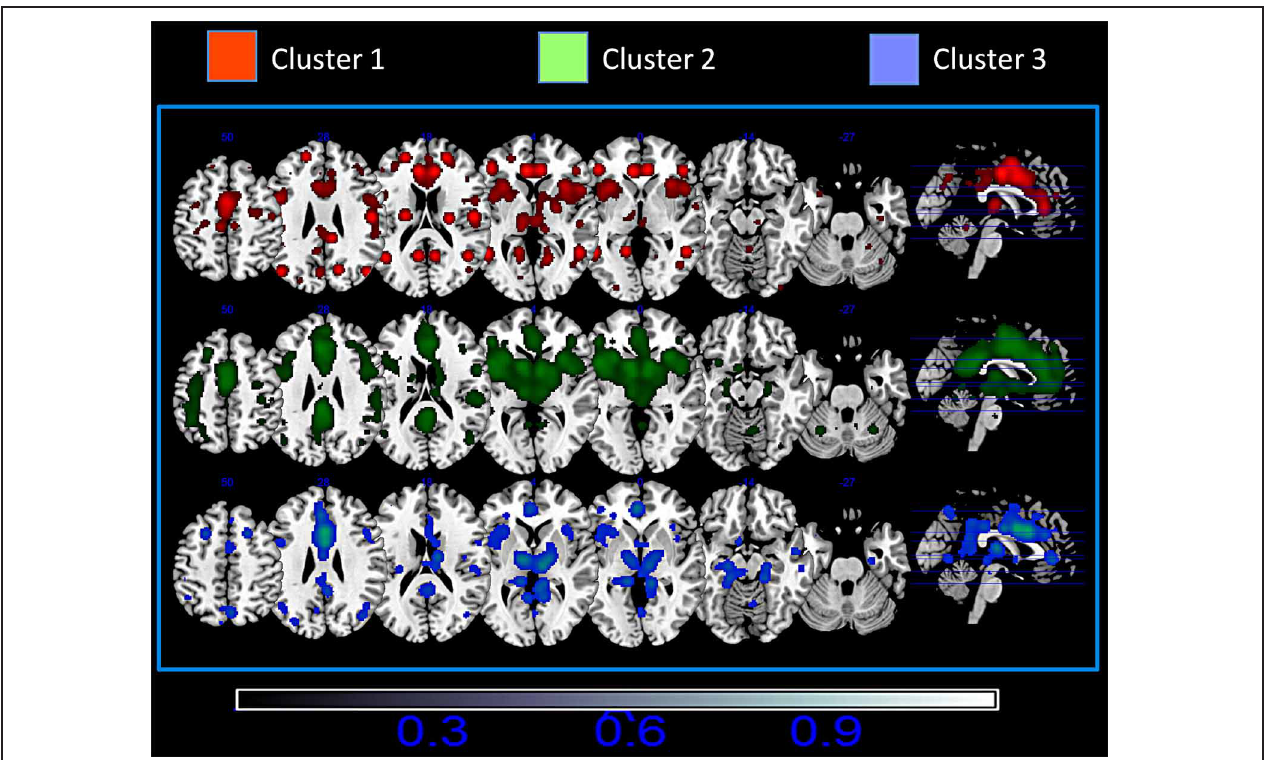
FIGURE 4 | Mean Meta-analytic connectivity of the three networks. ALE maps were computed at an FDR-corrected threshold of p < 0 . 05; minimum cluster dimension k > 100mm and visualized using MRIcron (http://www.cabiatl.com/mricro/mricron/index.html). 3